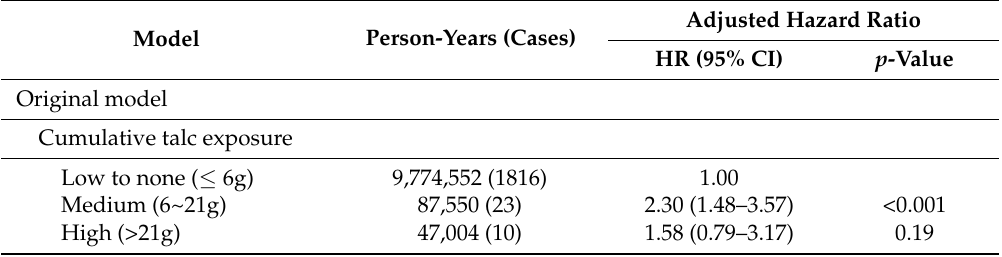
Table 4. Sensitivity analyses of talc exposure on the risk of stomach